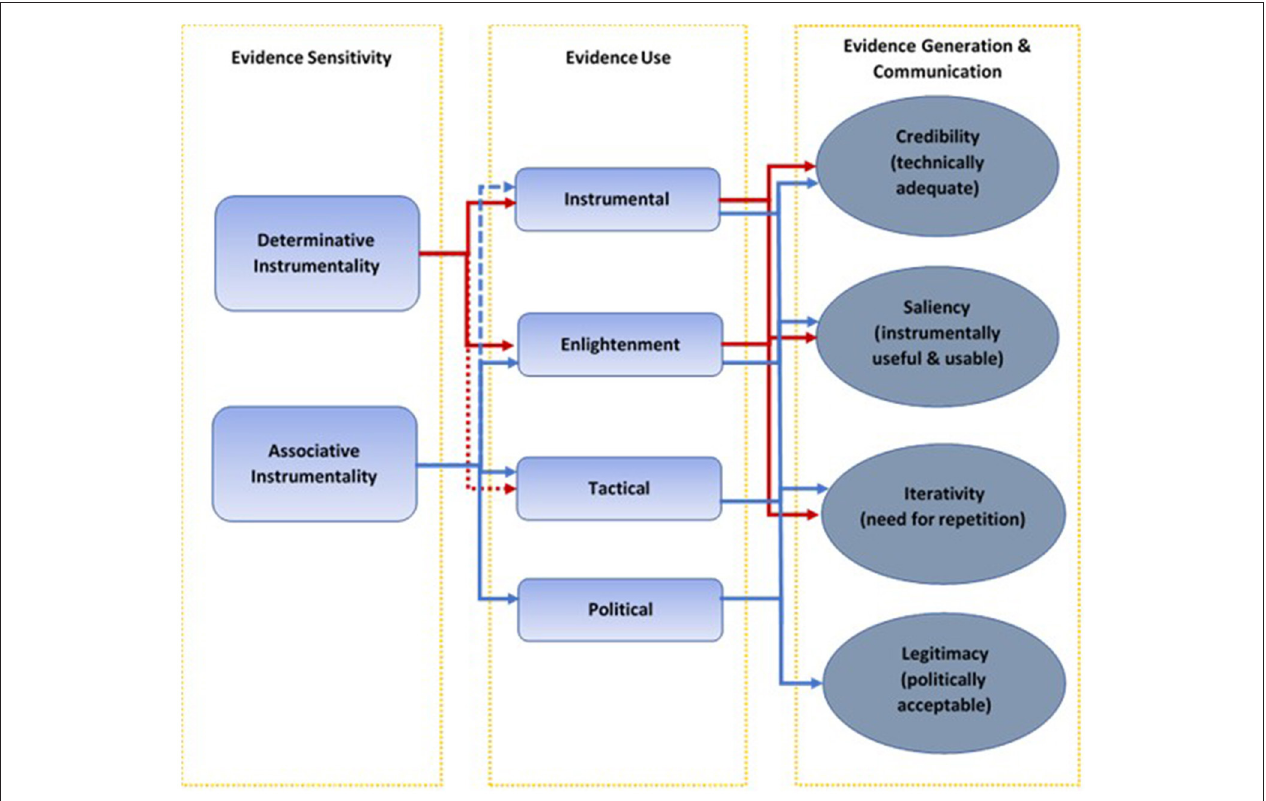
FIGURE 4 | A Critical Model of evidence use—Part 2: Evaluating evidence development and use based on evidence sensitivity invokes the broadest range of criteria for consideration at each step of the linear